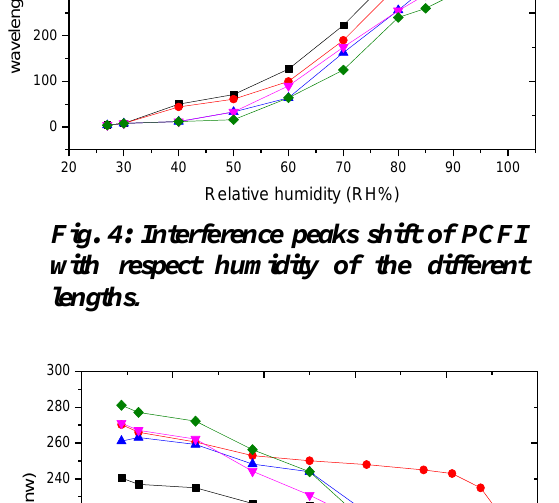
Fig. 6: Interference peaks shift of PCFI with respect humidity of the length 4 mm